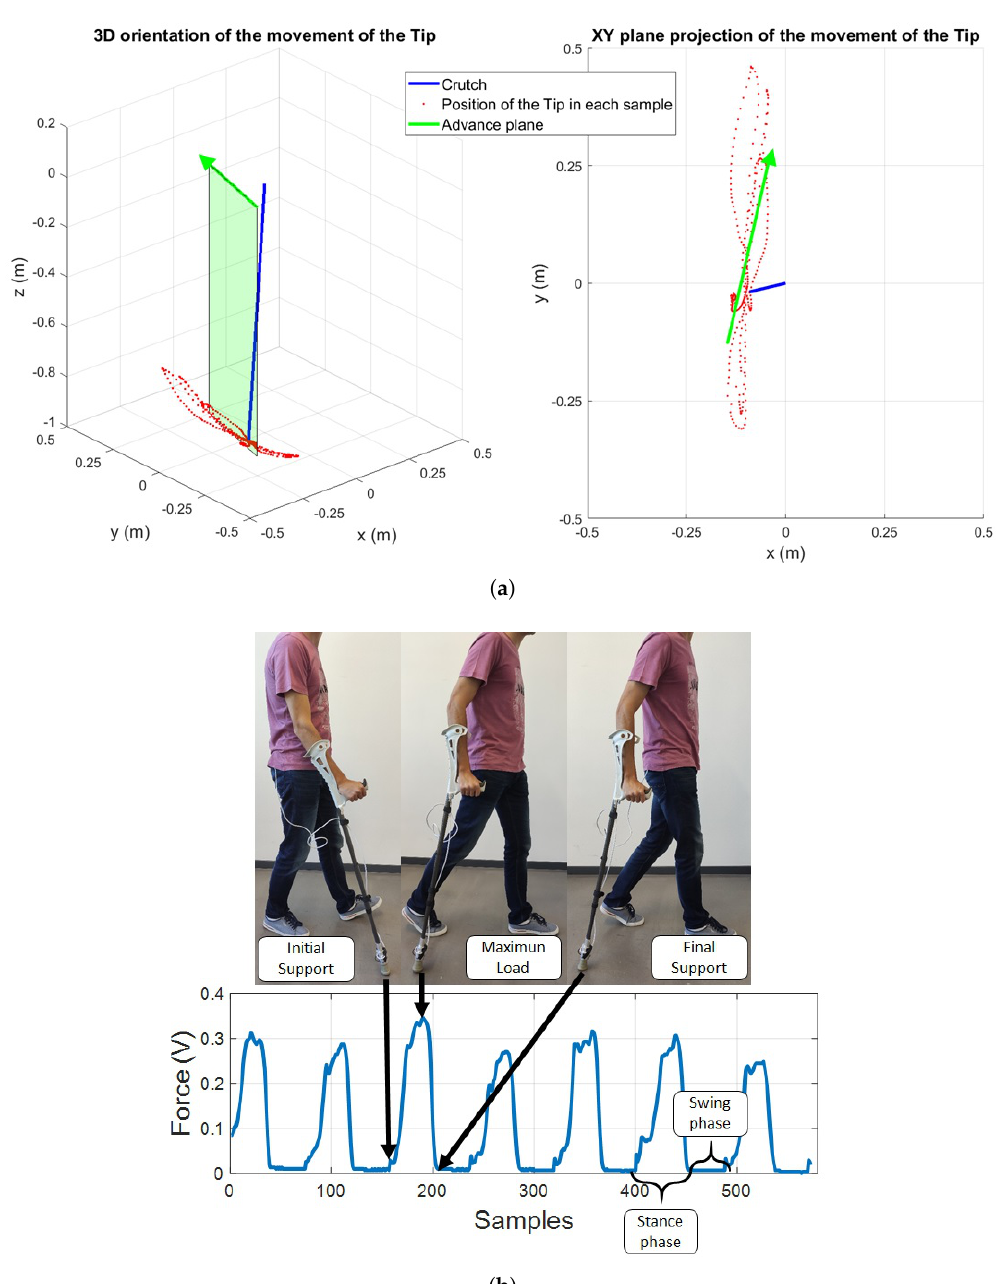
Figure 10. ( a ) 3D Orientation of the Sensorized Tip and ( XY ) plane projection. ( b ) Stance and Swing